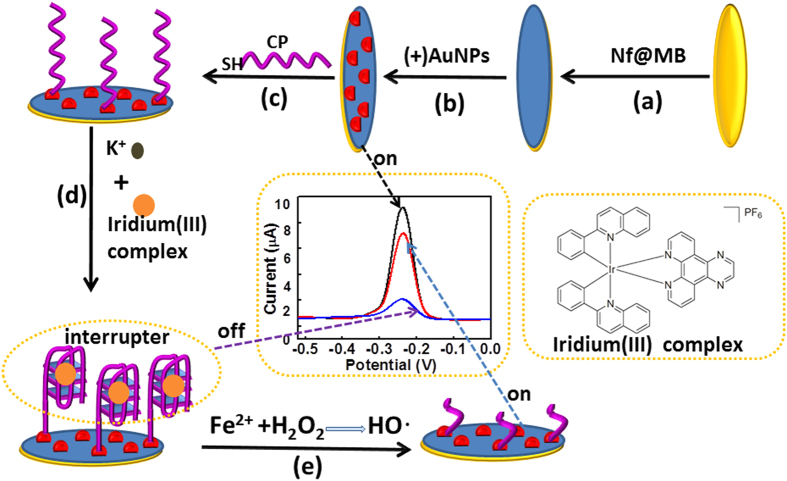
Scheme diagram for the preparation of H2O2 sensor.